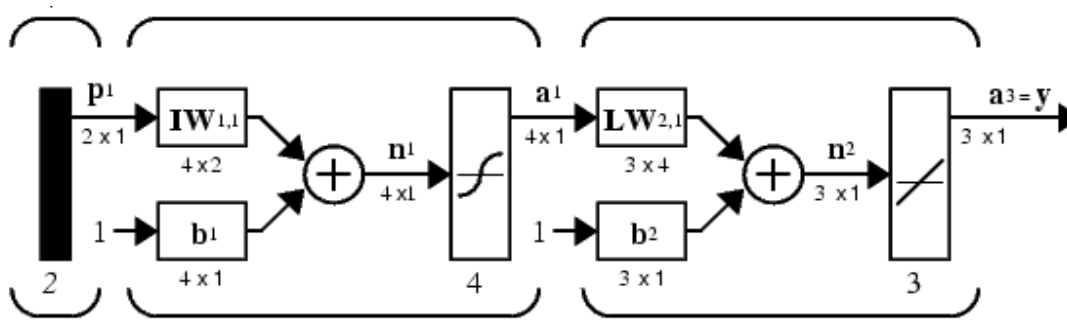
Fig. 4: The structure of the neural network FFBP